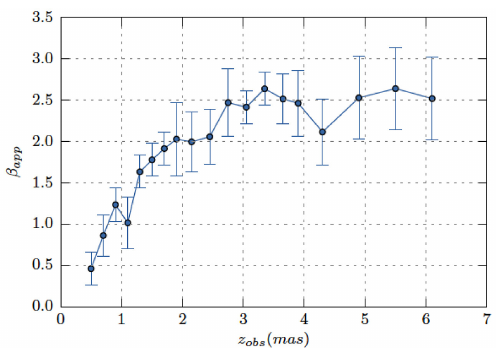
Figure 5. The speed of the faster system found using the Wavelet Image Segmentation and Evaluation (WISE) analysis as a function of distance from the core